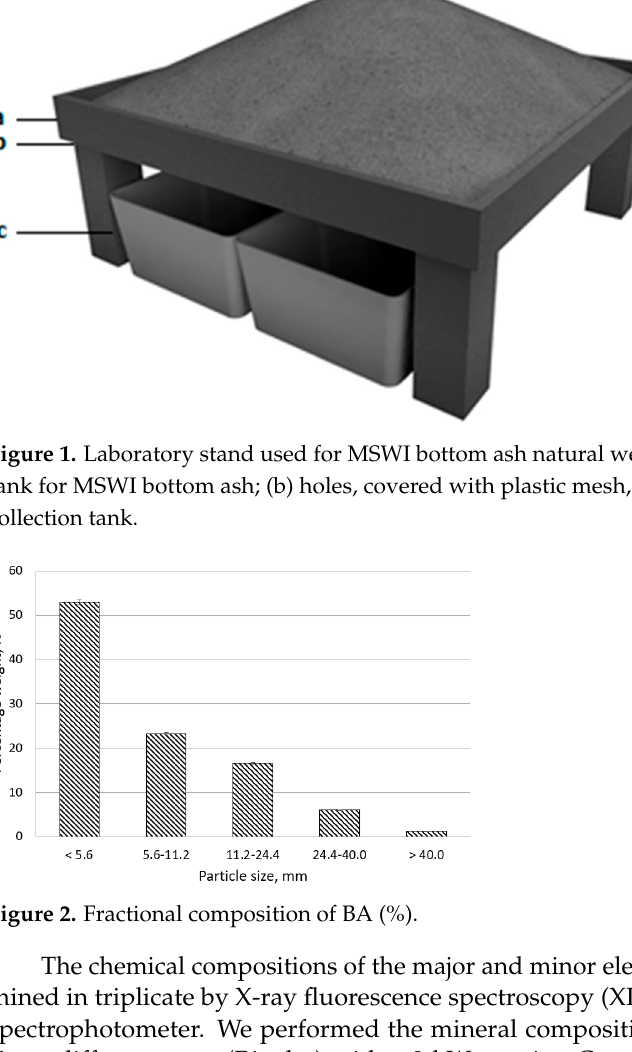
Figure 2. Fractional composition of BA (%).